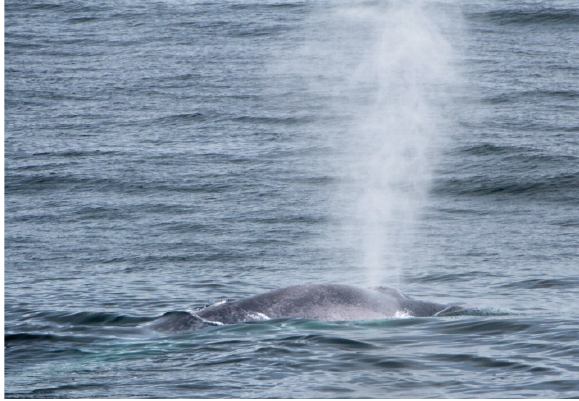
Figure 6. Blue whale. Photo credit: Natural History Museum, Faroe Islands. Pike, Gunnlaugsson, Víkingsson & Øien (2009c) provide uncorrected abundance estimates for all surveys up to 2001. No estimate is available for 2007 as there were only 14 sightings in that survey (Pike et al., 2019b). Abundance was highest in 1995 and 2001 at just over 1,000 animals and increased significantly over the period at a rate of 9% (95% CI 3% – 14%). Our uncorrected estimate (Supplementary file 4) is more than double those from 1995 and 2001, although not significantly different from either ( P >0.05). This suggests that blue whale numbers have increased in the area, particularly to the west of